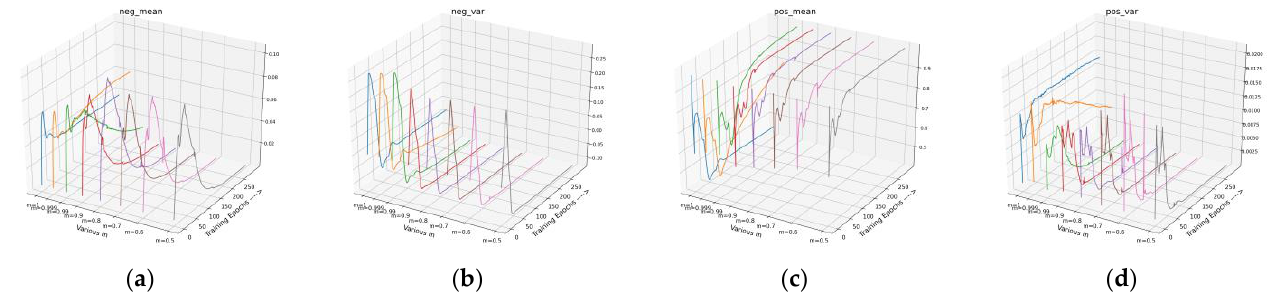
Figure 17. Similarity statistics of various 𝑚 in SCL training on the Indian Pines dataset: ( a ) mean of